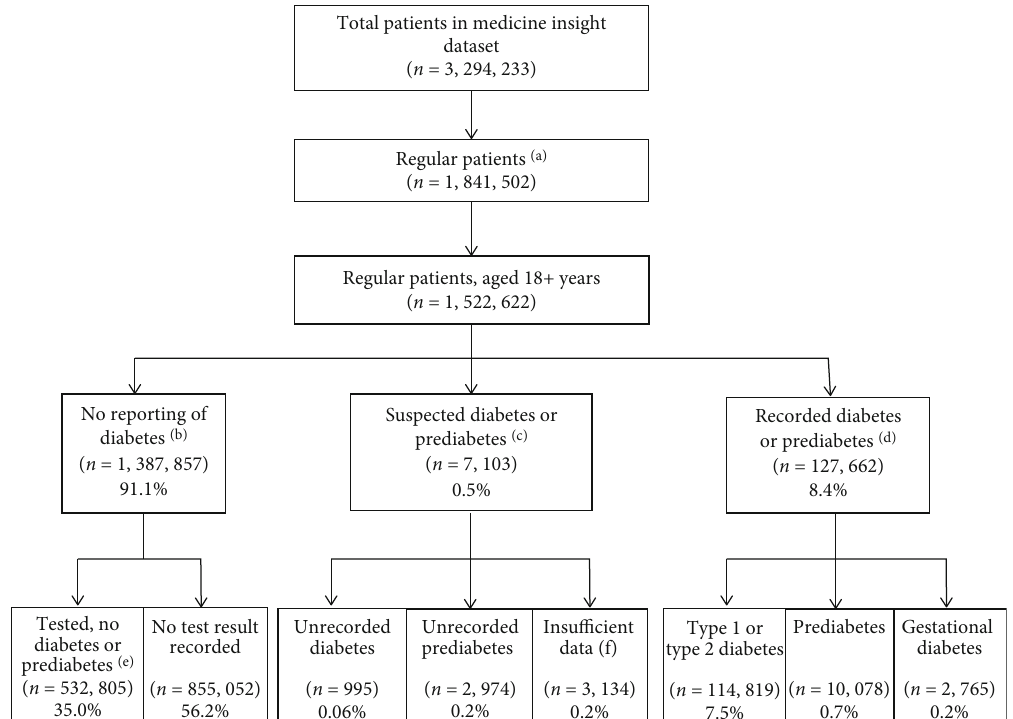
Figure 1: Flowchart of the distribution of patients included in the study, their screening status, and diagnosis of diabetes or prediabetes in Australian general practice. MedicineInsight, 2016-2018. (a) At least three consultations in two consecutive years and at least one in each year. (b) No recording of diabetes, either as a diagnosis, reason for encounter, reason for prescription, or receiving an antidiabetic medication over the three-year period. (c) One or more positive laboratory results for diabetes or prediabetes (details in Supplementary Table 1) but no recorded diagnosis of diabetes or prediabetes or prescription of antidiabetic medication. (d) Diagnosis (diabetes, prediabetes, and gestational diabetes) recorded in at least two di ff erent occasions either as a diagnosis, reason for encounter, reason for prescription, or patient was prescribed antidiabetic medication, or the diagnosis was recorded only once but the patient had a positive laboratory result consistent with diabetes or prediabetes. (e) At least one laboratory test recorded, all results negative for diabetes or prediabetes. (f) Only one positive blood test for diabetes or prediabetes recorded, but no recorded diagnosis or prescription for diabetes/